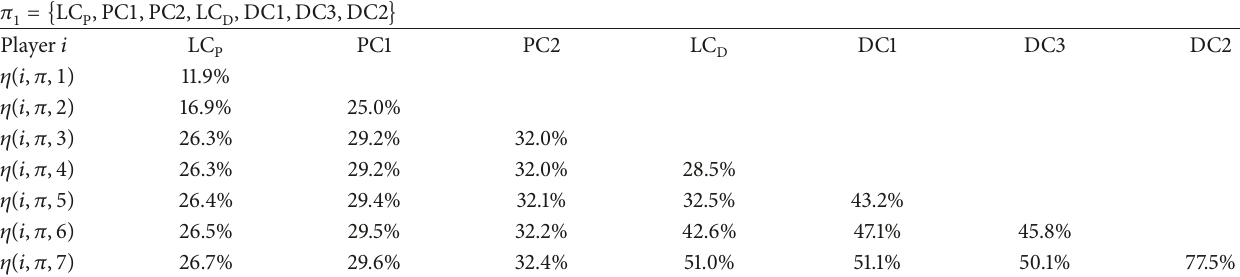
Table 8: SMP based grand coalition